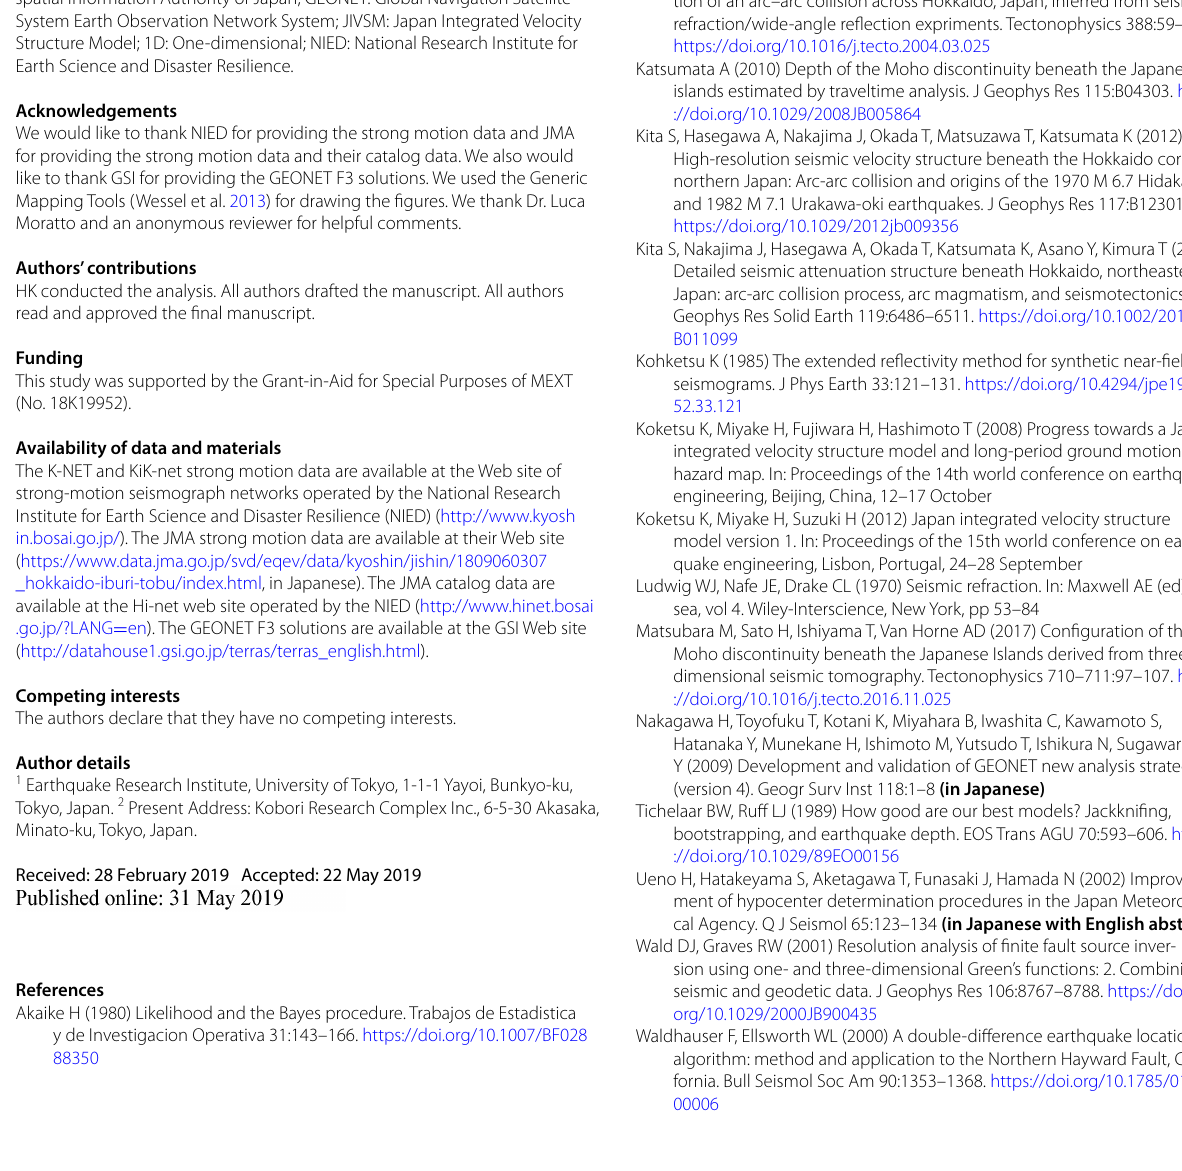
Additional file 1: Figure S1. Rupture front velocity versus waveform vari- ance for the two fault-plane model. Figure S2. Slip distribution for various rupture front velocities ( V r